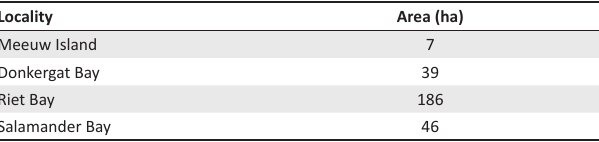
FIGURE 6: Donkergat Military Training TABLE 1: Area sizes of regions of Donkergat Military Training Area to be included in the Langebaan Ramsar site. Locality